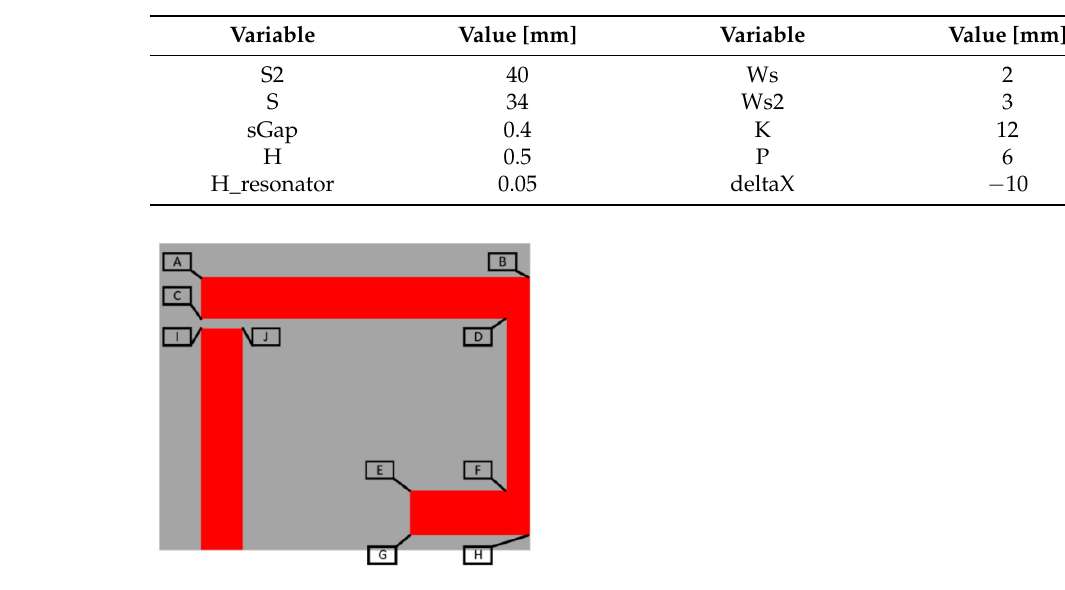
Table 6. FEA sensor specifications.